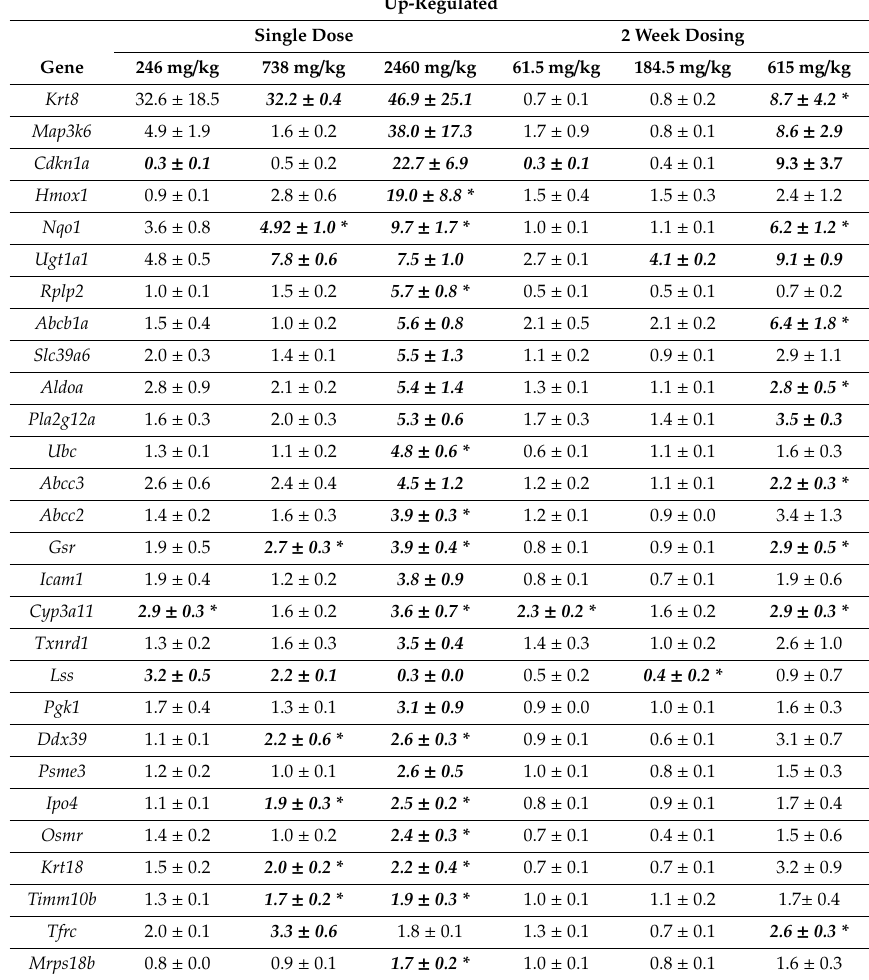
Table 3. Gene-markers of hepatotoxicity a ff ected by CBD administration. Genes that are significantly up- or down-regulated sorted by greatest fold changed at the highest dose (2460 mg / kg or MED of 200 mg / kg). Cells in bold italics indicate those significantly di ff erent from vehicle (One-Way ANOVA, indicated by *, or Kruskal-Wallis test with appropriate post-hoc comparison). Genes that are commonly and significantly dysregulated in both the acute and sub-acute studies are highlighted in yellow. Data presented as mean ± SEM ( n = 6 / group) fold change from